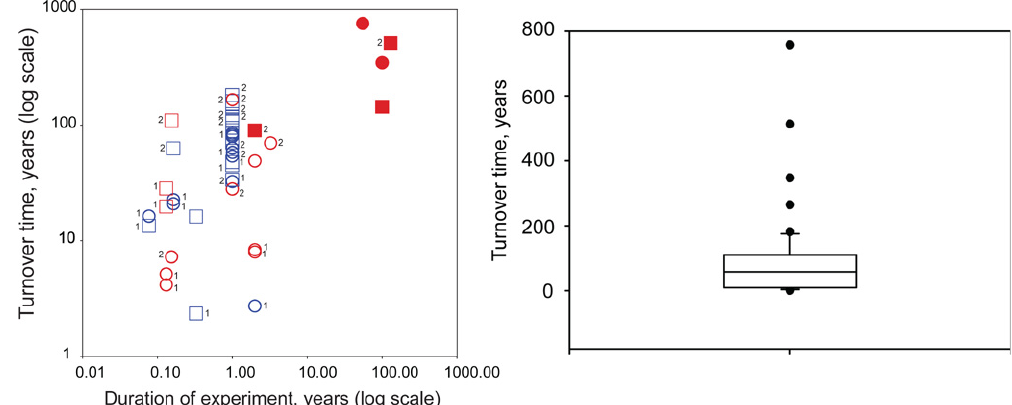
Fig. 2. PyC has an average turnover time of 88 years and ranges from < 1y to 750y based on first-order decay model. Turnover time calculated using first-order decay vs. duration of experiment (left). The empty symbol represents incubation studies, filled symbol represents field-based studies, circles correspond to grass PyC, squares correspond to wood PyC, colour represents sand (blue) and soil (red) medium, the numbers represent temperature of pyrolysis: (1) for < 400 ◦ C and (2) for ≥ 400 ◦ C. There is a weak relation between experiment duration and individual turnover time ( r 2 = 0 . 49), showing experiment duration is not the only factor influencing turnover time. Box plot of individual turnover time for each study (right), where filled black circles are outliers beyond 5th or 95th